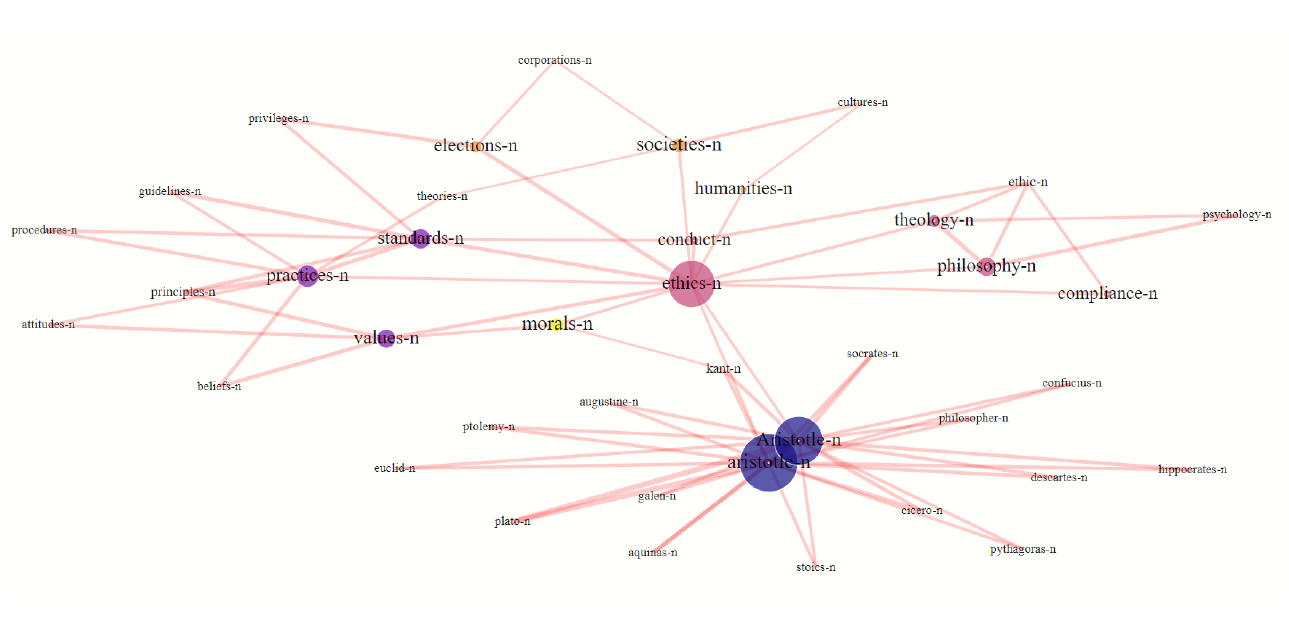
Figure 1. FoF [ and | or ] ethics : ConGraCNet graph representation of the sense structure of a source noun lexeme ethics in